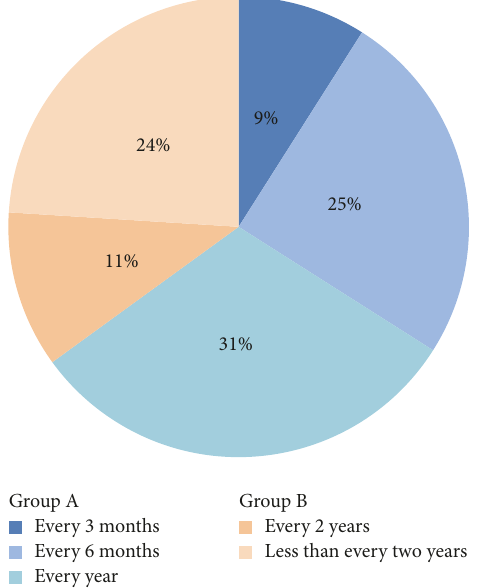
Figure 1: Frequency of dental visits for 1,607 patients with oral squamous cell carcinoma.